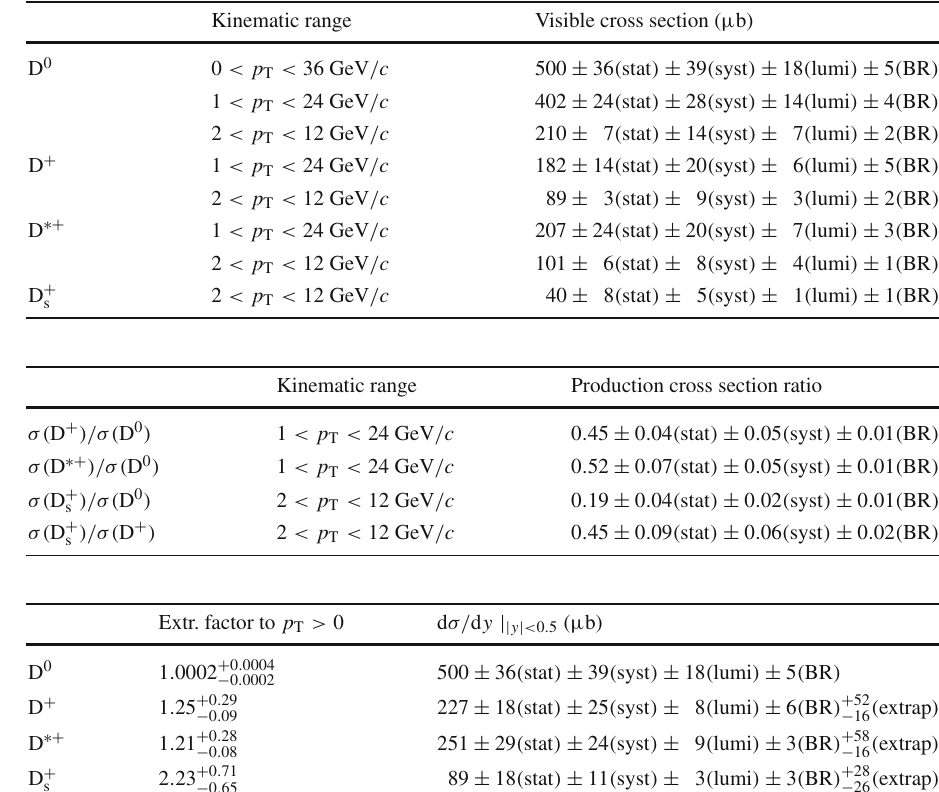
cross sections of prompt D mesons in | y | < 0 . 5 in pp √ s = 7 TeV collisions at